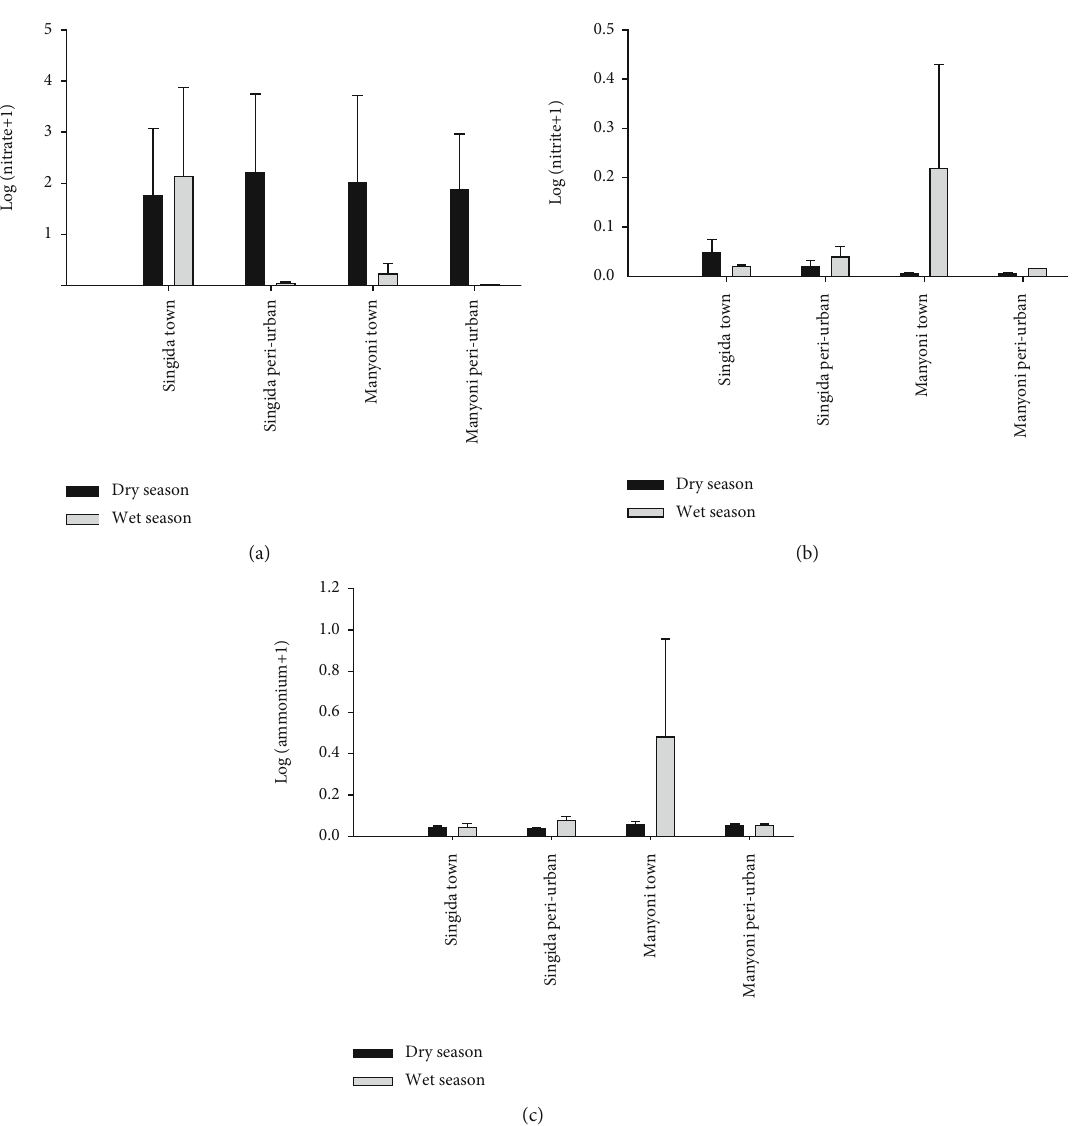
Figure 2: The logarithmic distribution of (a) nitrates (ppm), (b) nitrite (ppb), and (c) ammonium (ppb) of boreholes in Singida and Manyoni towns and peri-urban areas during the dry and wet